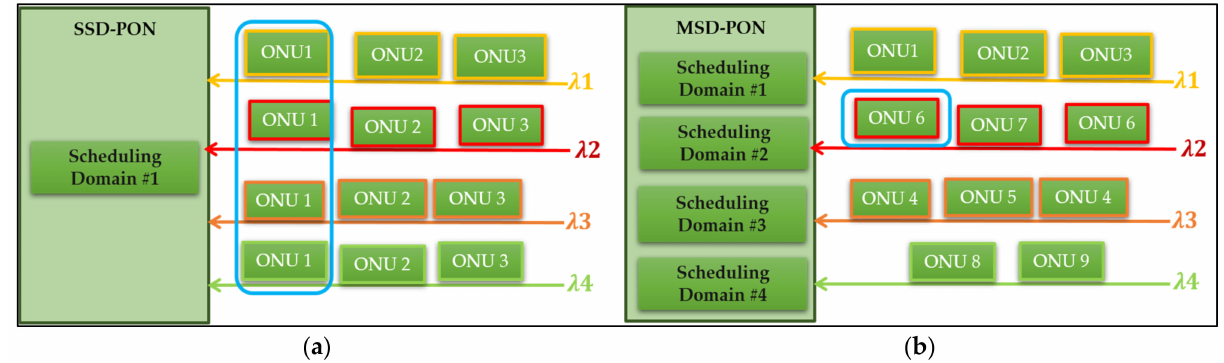
Figure 6. Illustrations of the passive optical network (PON) solutions ( a ) single-scheduling domain (SSD), ( b ) multi- scheduling domain